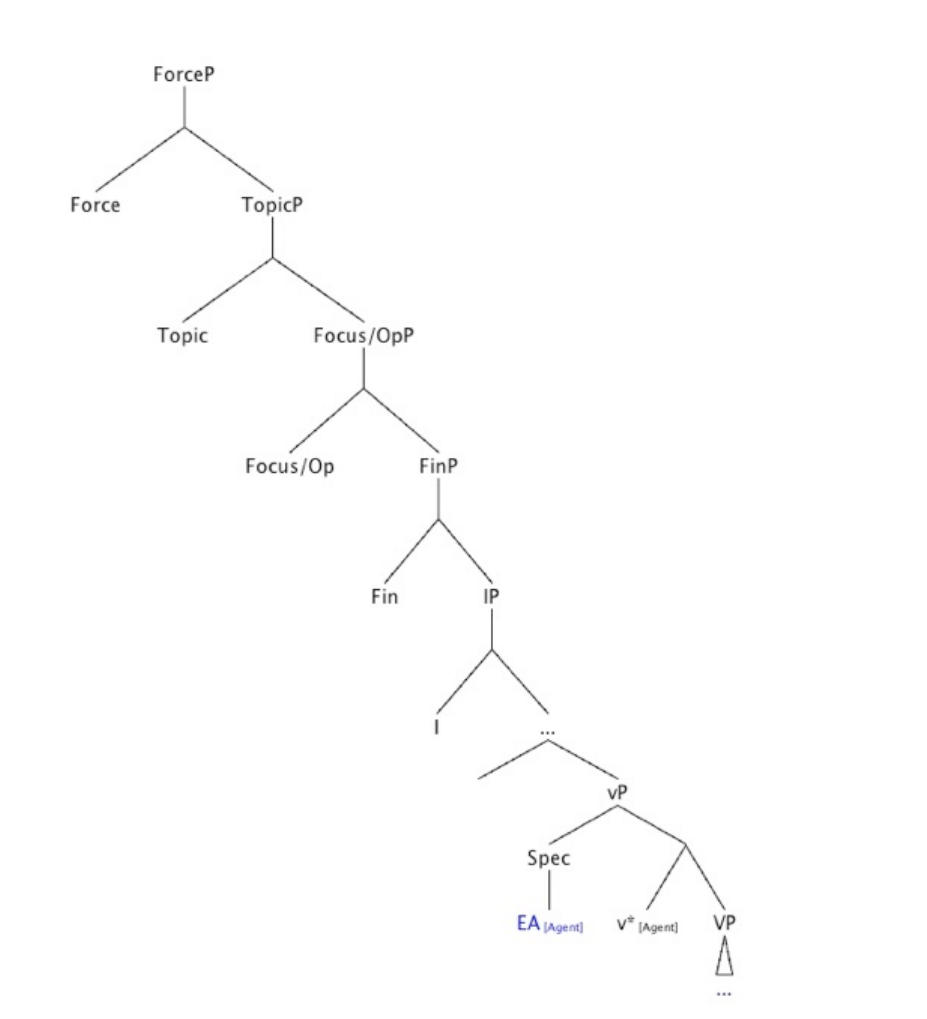
Figure 2 . Renaissance Italian active clause